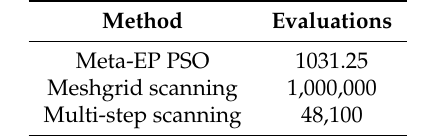
Table 5. Comparison of different